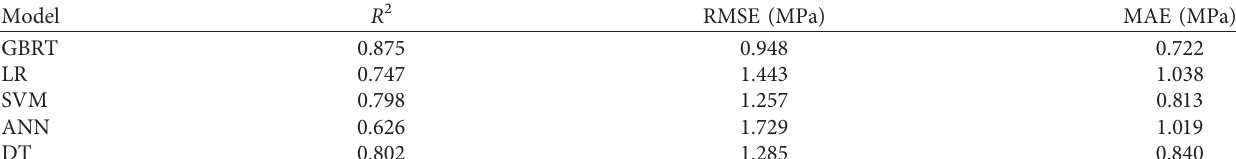
Table 5: Comparisons of predictive performance between GBRT and general ML models. Model